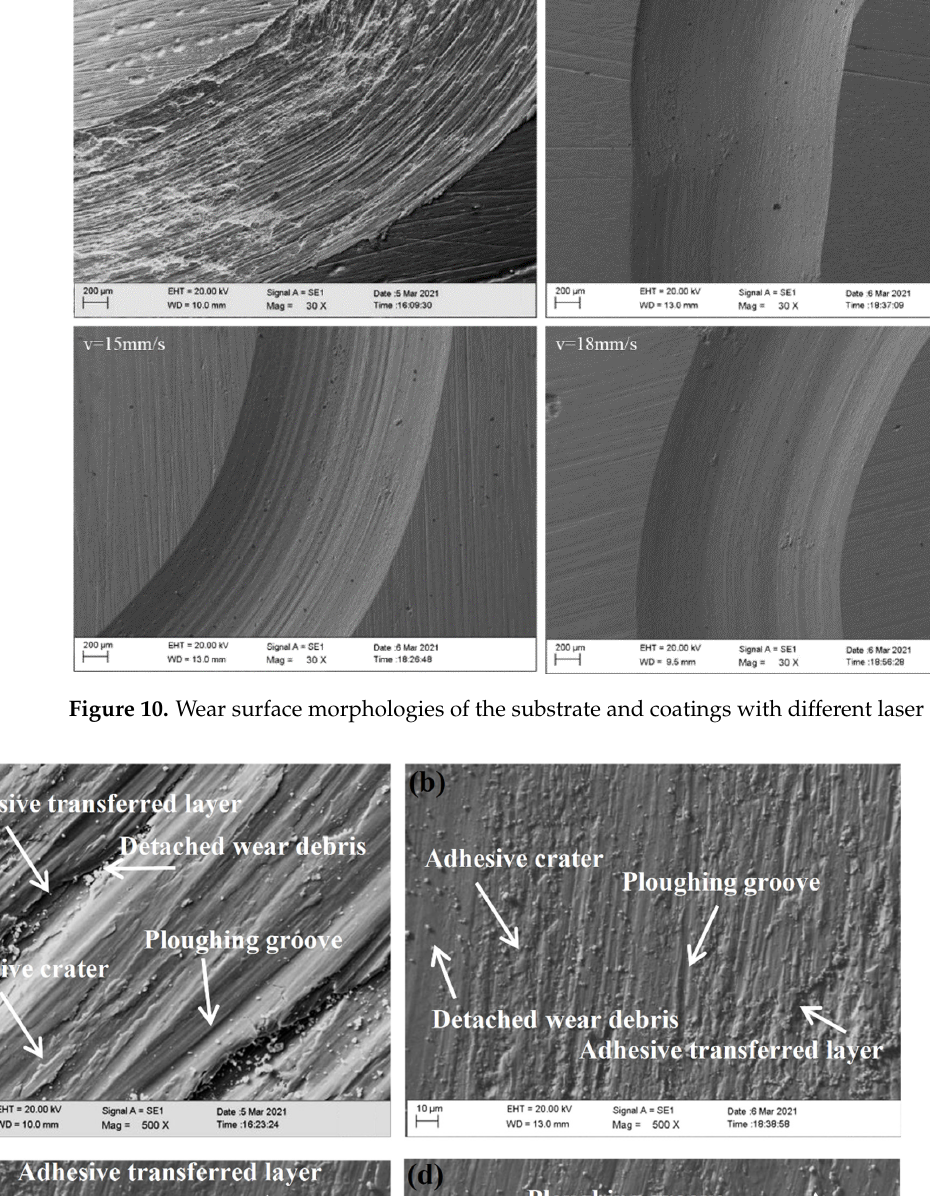
Figure 12. EDS analysis results of wear debris in Figure 11c. 4. Conclusions This study employed G@Ni as the alloying material to prepare coatings with high surface quality and metallurgical bonding on a Ti-6Al-4V substrate using laser alloying.